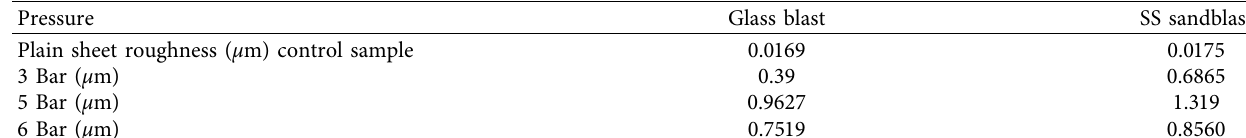
Table 3: Surface roughness for blasted aluminium skin.